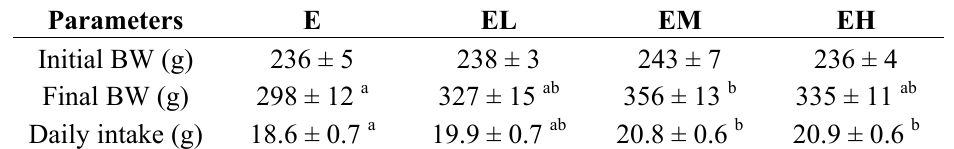
Table 1. Initial and final body weight and daily food intake of rats in each group.